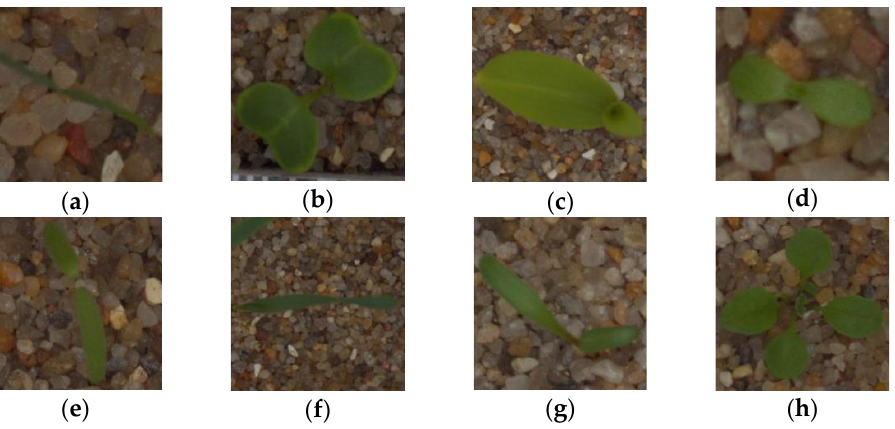
Figure 1. Examples of partial samples of ( a ) black-grass; ( b ) charlock; ( c ) maize; ( d ) scentless mayweed; ( e ) fat hen; ( f ) common wheat; ( g ) sugar beet; and ( h ) shepherd’s